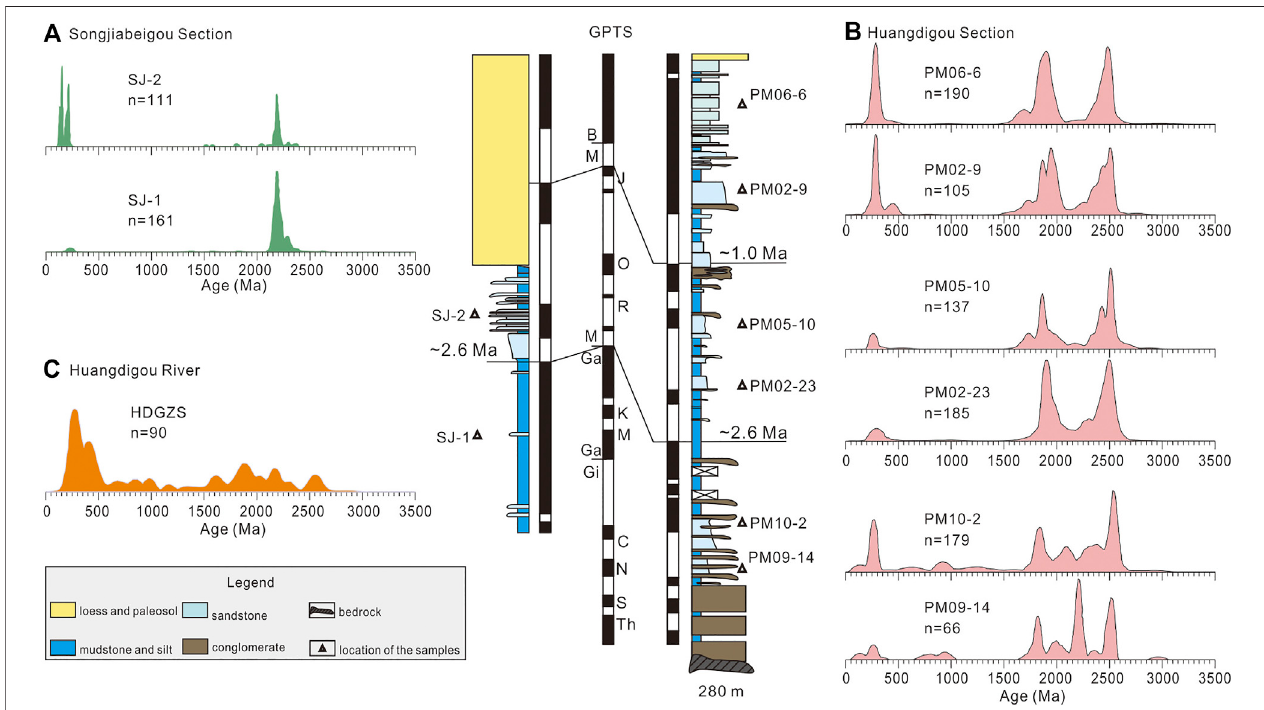
FIGURE2| Kerneldensity estimationplotsofthezircon U-Pbages fromtheSongjiabeigou Section (A) ,Huangdigou Section (B) ,andHuangdigouStream (C) and the corresponding lithostratigraphy and chronological framework [referenced by Hu et al. (1993) and Wang et al. (1999)].